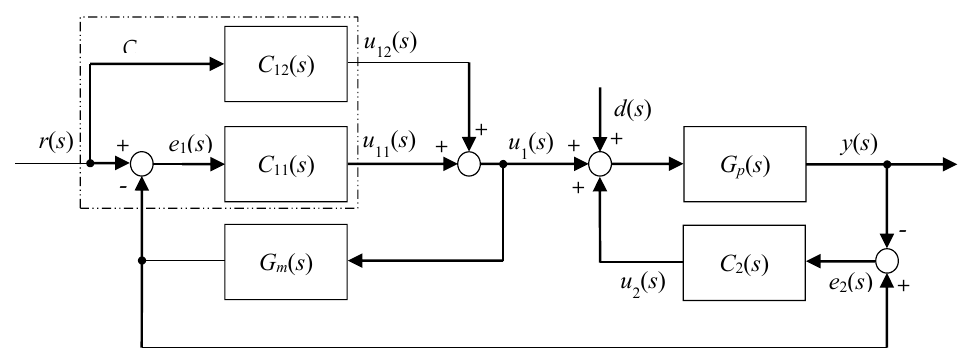
Figure 1. Modified two-degree-of-freedom (2-DOF) control framework.